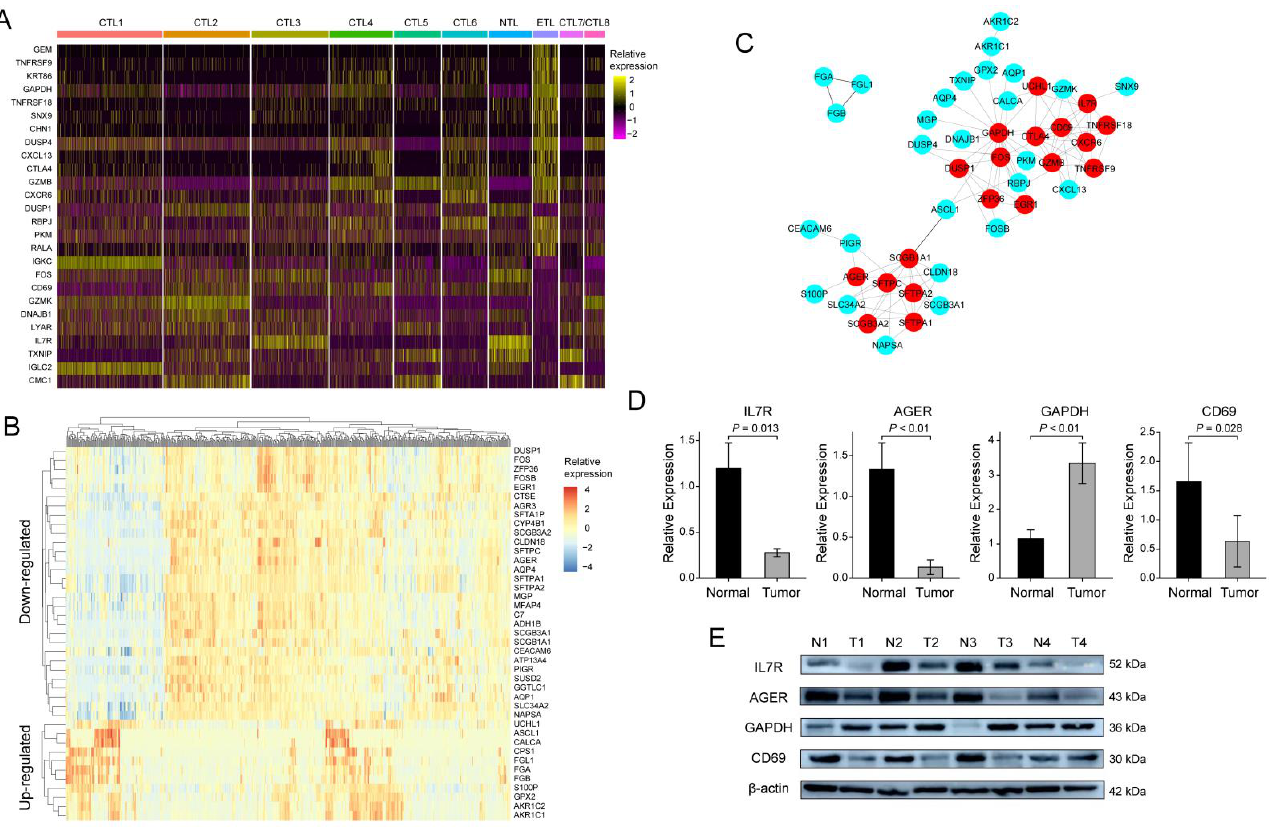
Figure 3. Screening of hub genes and validation of clinical samples: ( A ) 26 DEGs between the ETL subset and other CD8+ T cell subsets; ( B ) 41 DEGs among TCGA-LUAD samples with high and low proportions of ETL subset; ( C ) protein interaction network of 65 DEGs; ( D ) RT-qPCR results of IL7R, AGER, GAPDH, and CD69 in 24 pairs of LUAD samples; ( E ) Western blot results of IL7R, AGER, GAPDH, and CD69 in 4 pairs of LUAD samples.